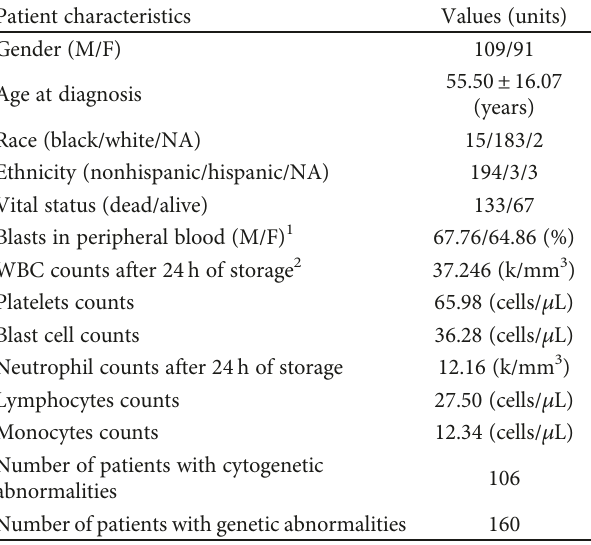
Table 1: Characteristics of AML